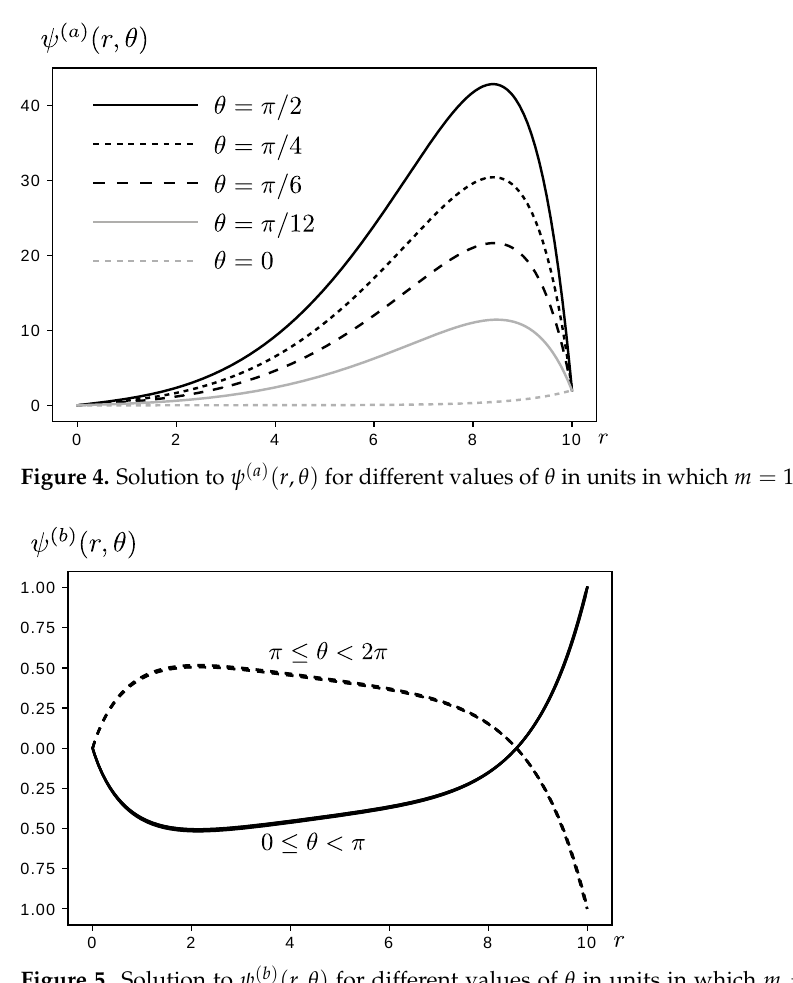
} , the dotted line for θ = {− π , π , π , π 6 2 12 4